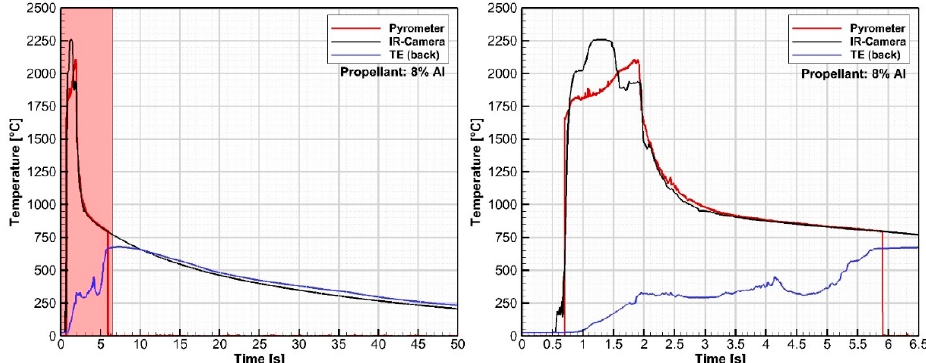
Figure 10. Temperature data from the 8% Al propellant test measured on front and back sides of the sample; ( left ) results from the duration of the experiment, ( right ) expanded view of red shaded region.